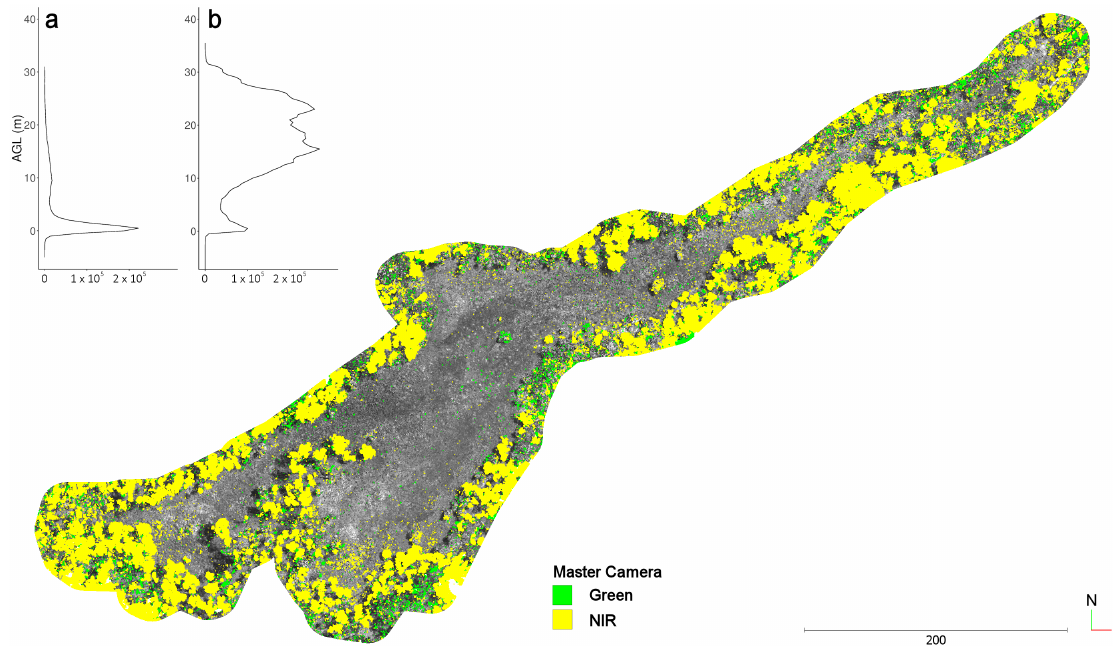
Figure 10. (main) Summer T2 dense point cloud features for the green band master (green) and NIR band master (yellow), with dense point features of both products separated by less than 0.5 m. The number of unique dense point elevations above ground level (0.5 m bins) is shown for ( a ) green and ( b ) NIR dense